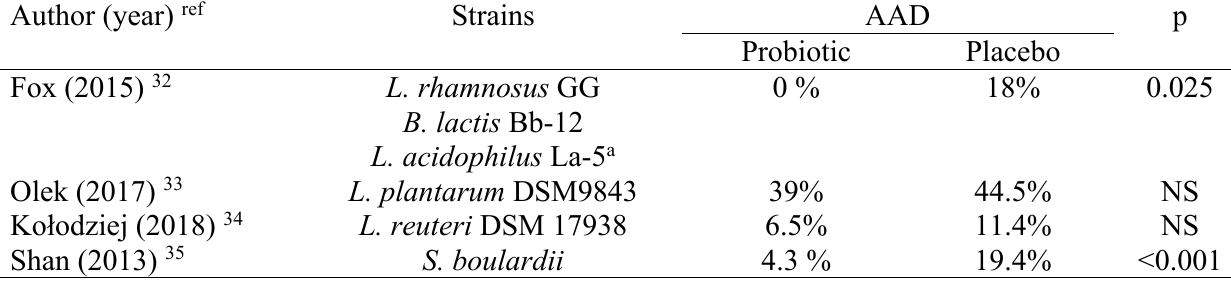
Table 3. Probiotics and prevention of antibiotic associated diarrhea Author (year)